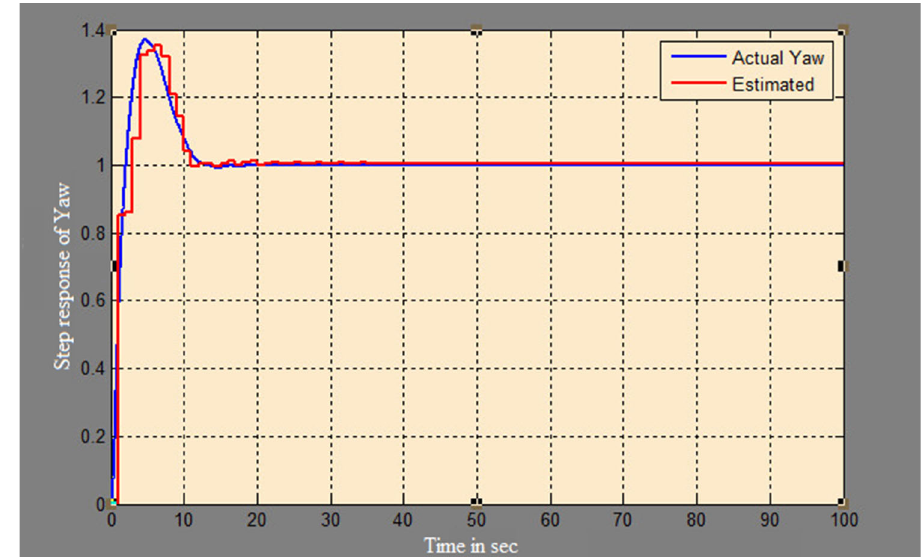
Figure 16. Estimation of yaw with the neural network